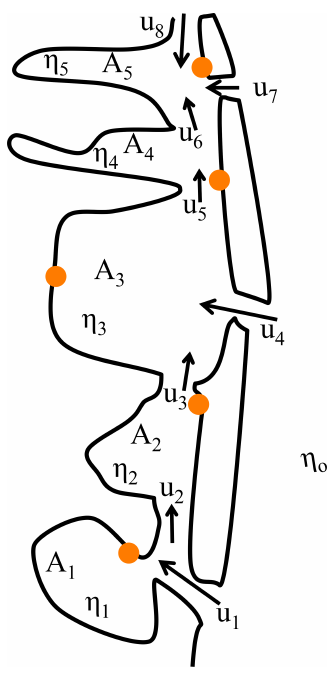
Figure 2. Schematic diagram of the ocean–inlet–bay system: A j is the surface area of the bays, η j the sea level in the bays, η 0 the sea level in the ocean, and u j is the velocity through channel j . The correspondence with the real bay system includes areas from the bays (Great Bay, A 1 ; Little Egg Harbor, A 2 ; Barnegat Bay, A 3 ; Toms River sub-embayment, A 4 ; north of Mantoloking, A 5 ), flow through inlets (Little Egg Inlet, u 1 ; Barnegat Inlet, u 4 ; the Point Pleasant Canal, u 8 ; and Mantoloking breach, u 7 ), and flow between bays (Tucker Island, u 2 ; Route 72, u 3 ; Bayville, u 5 ; Mantoloking, u 6 ). The location of the water level stations are indicated with dots, and the names and specifications are in Fig. 1 and Table